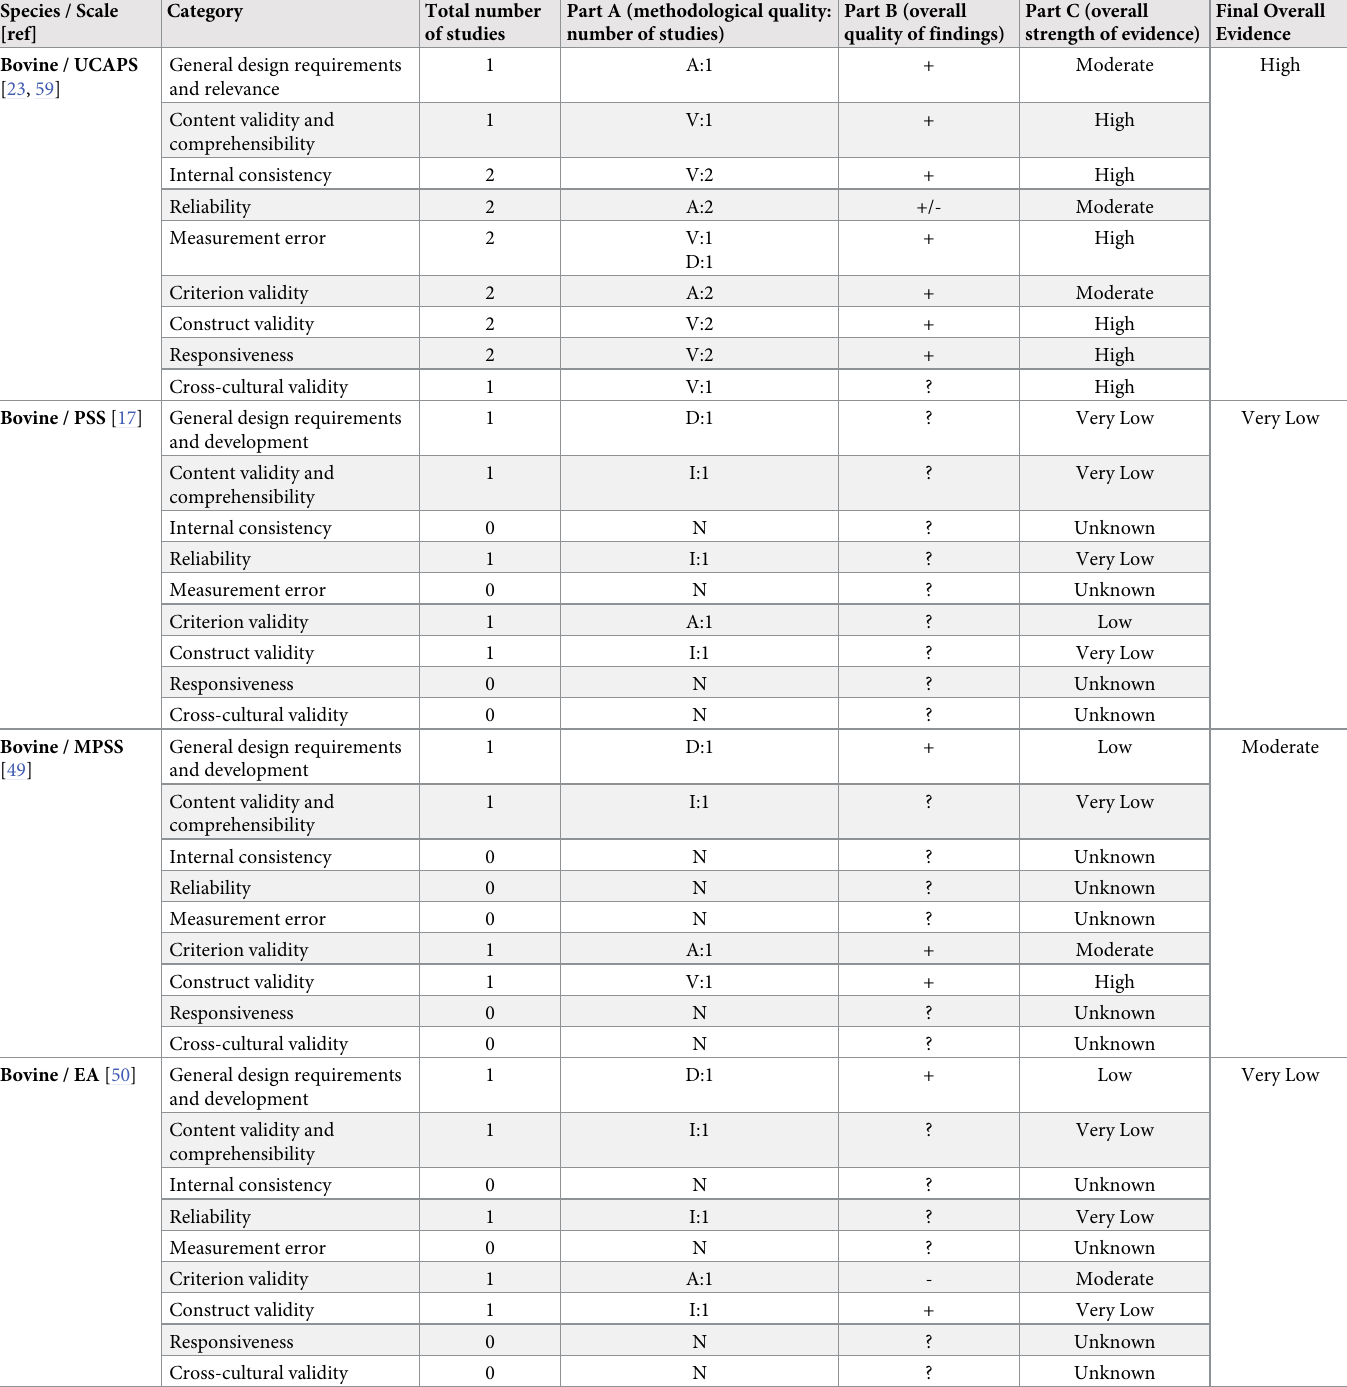
Table 5. Summary of the consensus scores for each pain scoring instrument in farm animals regarding assessment of methodological quality (Part A), quality of the findings (Part B) and quality of evidence (Part C), according the order of analysis. Species / Scale